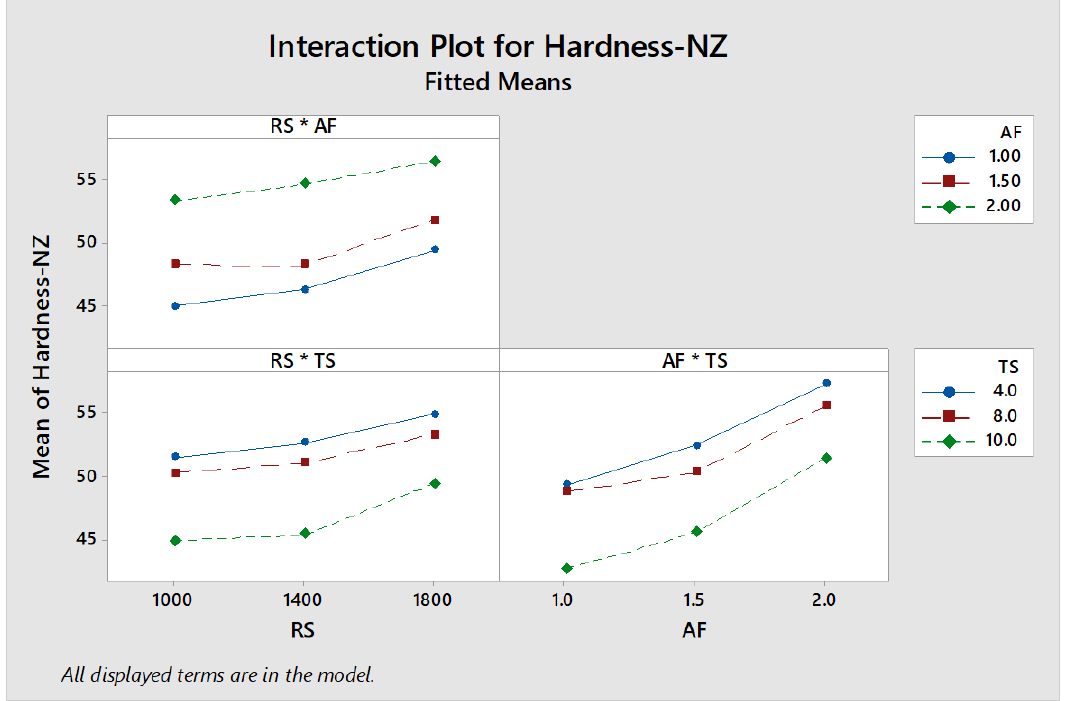
Figure 21. Interaction plots — hardness in NZ.